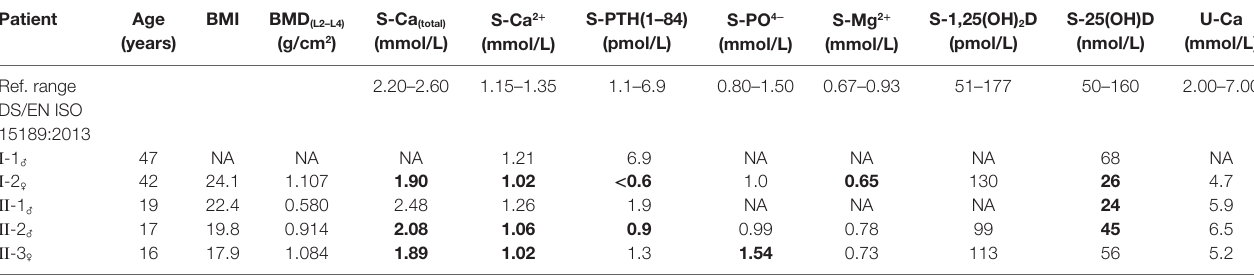
Table 1 | The biochemical baseline characteristics of the ADH family members investigated.